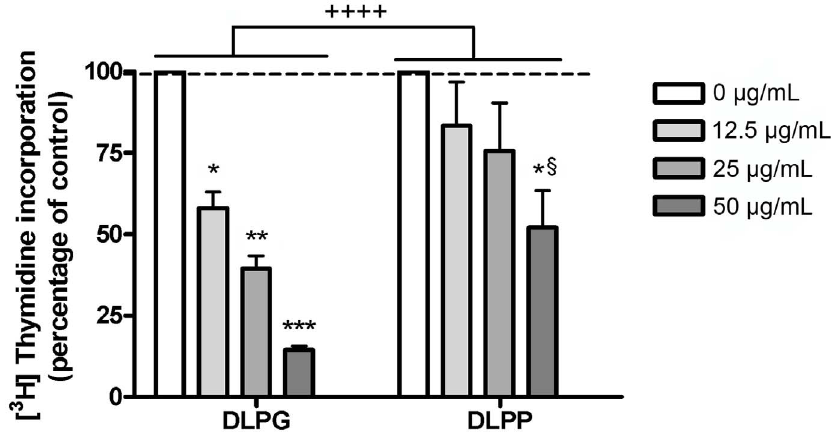
Figure 5. Comparison of the Effects of DLPG and DLPP on Keratinocyte Proliferation. Near-confluent to confluent keratinocytes were treated for 24 hrs with the indicated concentrations of liposomes composed of DLPG or DLPP, prepared via bath sonication of the phopholipid in SFKM. [ 3 H]Thymidine incorporation into DNA was then determined. Values represent the means 6 SEM of more than 3 separate experiments performed in duplicate; **p , 0.01, ***p , 0.001 versus the control value (0 m g/mL); 1 p , 0.05 versus the corresponding concentration of DLPG; ++++ p , 0.0001 as indicated. [ 3 H]Thymidine incorporation into DNA in the control was 50,400 6 7,500 cpm/well, and 53,300 6 6,400 cpm/well for DLPG and DLPP, respectively.